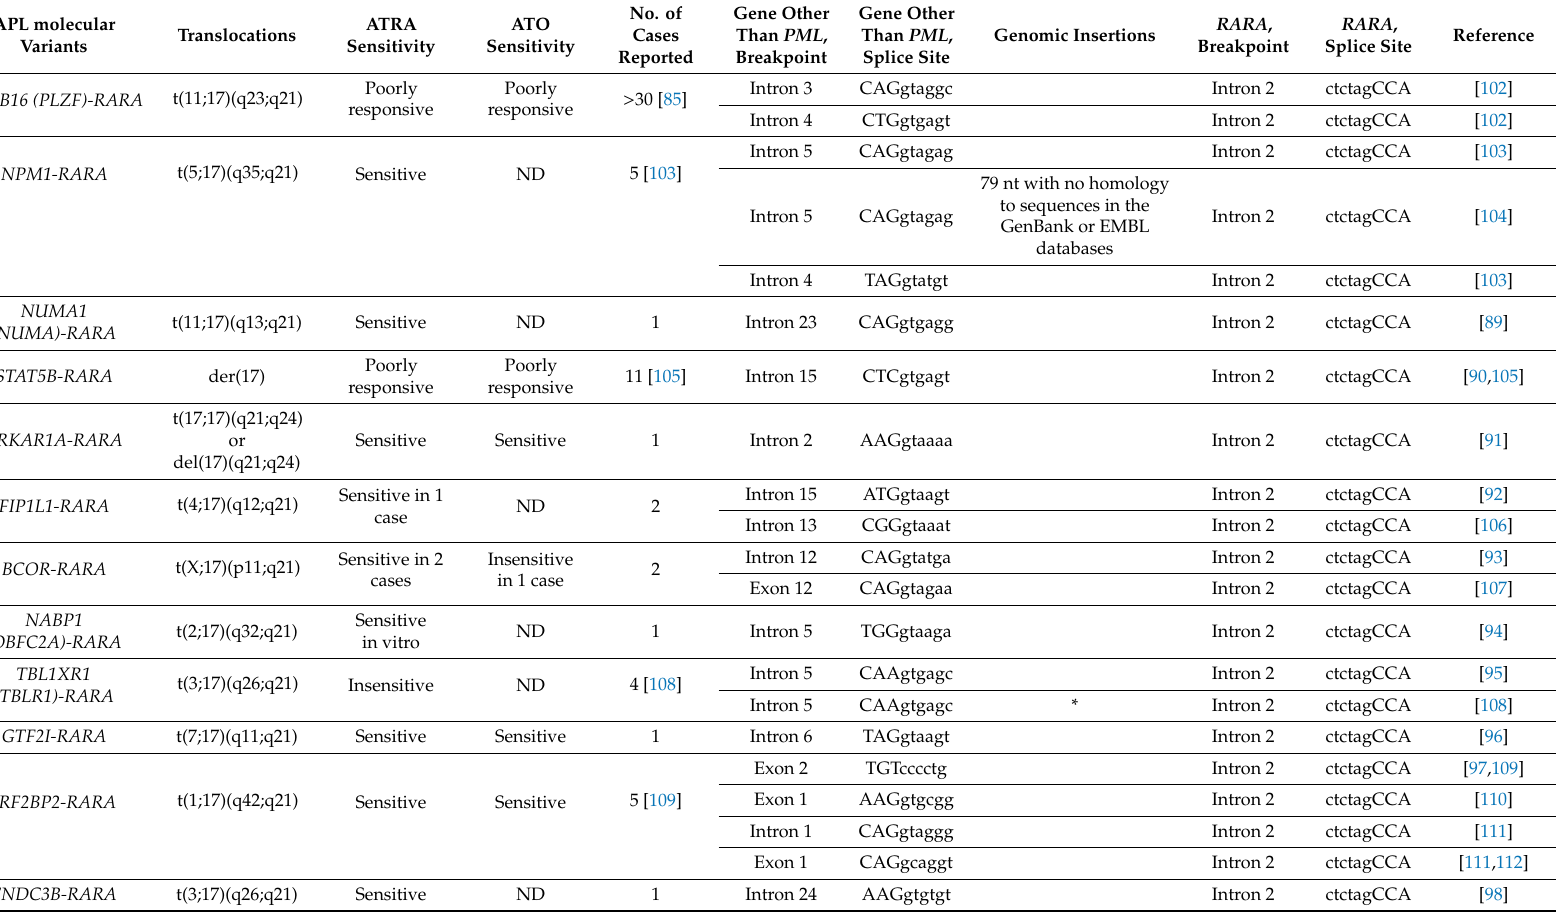
Table 2. APL molecular